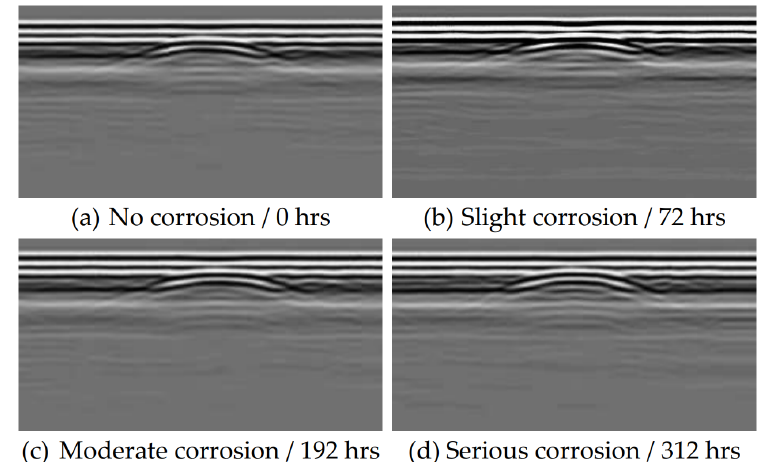
Figure 12. GPR Scanning Profile of Steel Bar Corrosion (thickness of 9 cm).